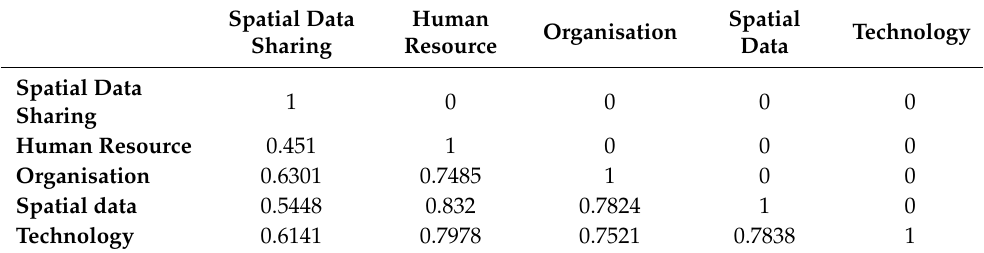
Table 10. Level of correlation of some aspects of spatial data sharing in KL.